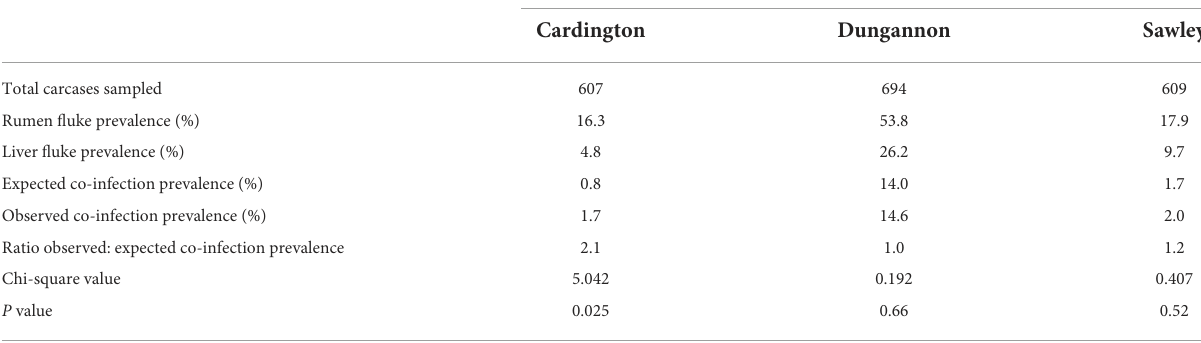
TABLE 2 The prevalence of adult rumen fluke, liver fluke or both in cattle carcasses from three abattoir sites in the United Kingdom.